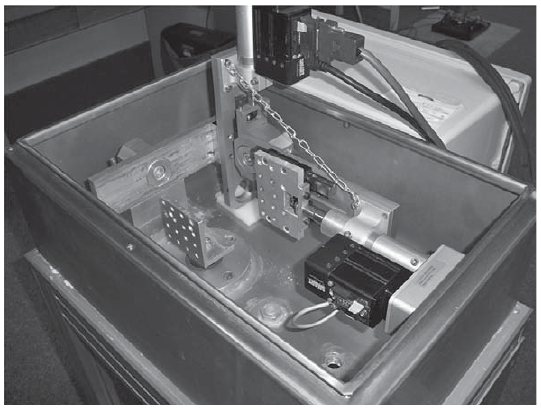
Fig. 1. The mastication mechanism within the fluid basin. The hor- izontal linear actuator (right) and the compression piston (coming through the bottom of the basin) are attached to the temporal bone and the mandible,